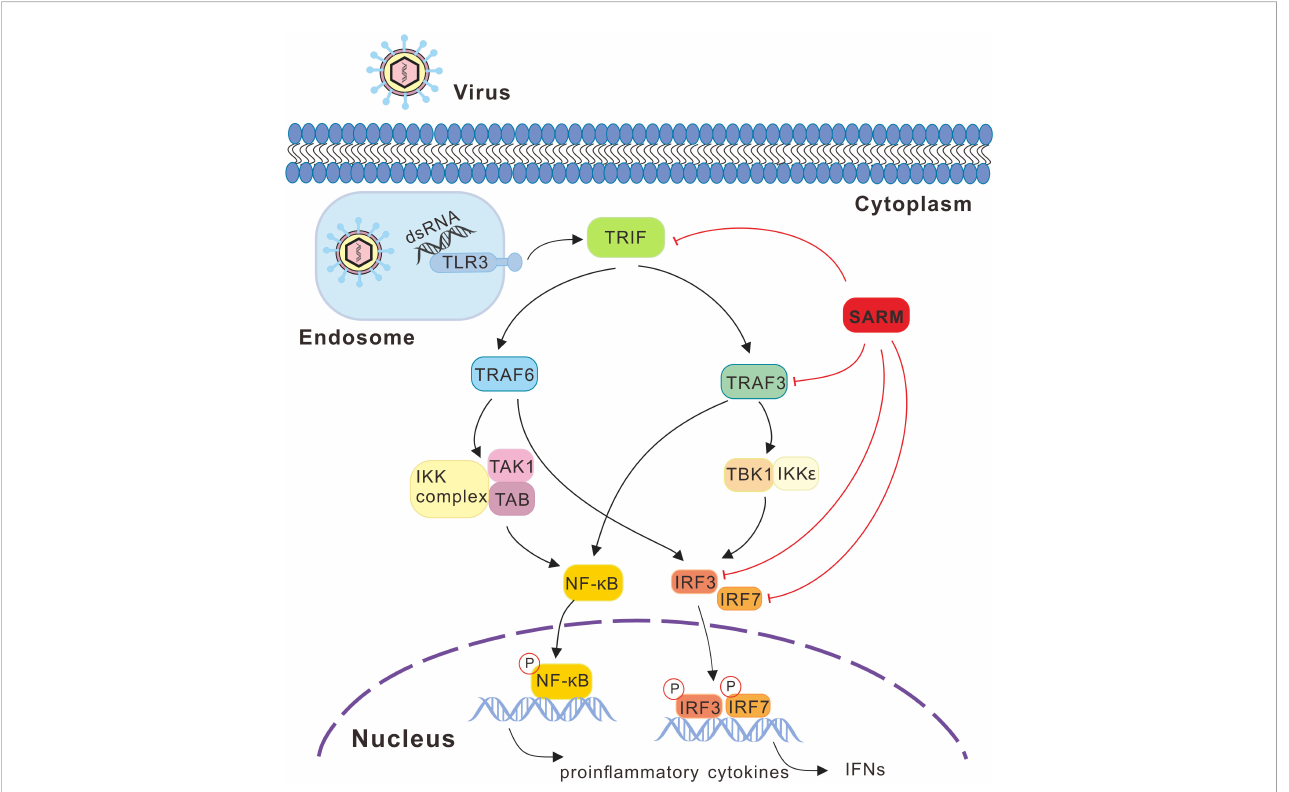
FIGURE 13 SARM mediated signaling pathway in response to viral infection in large yellow croaker. Recognition of viral PAMPs such as dsRNA through TLR3, which then recruits the adaptor protein TRIF, subsequently actives the downstream TRAF3 and TRAF6, leading to the activation of transcription factors including NF- k B and IRF3/7 and then initiating the production of proin fl ammatory cytokines and type I IFNs. During the signaling cascade, large yellow croaker SARM could associate with TRIF, TRAF3, IRF3, and IRF7 and acts as an inhibitor in such molecules mediated signaling. In the signaling schematics, the involved signaling pathway is presented with lines and arrows, with the negative regulation cascades marked with red